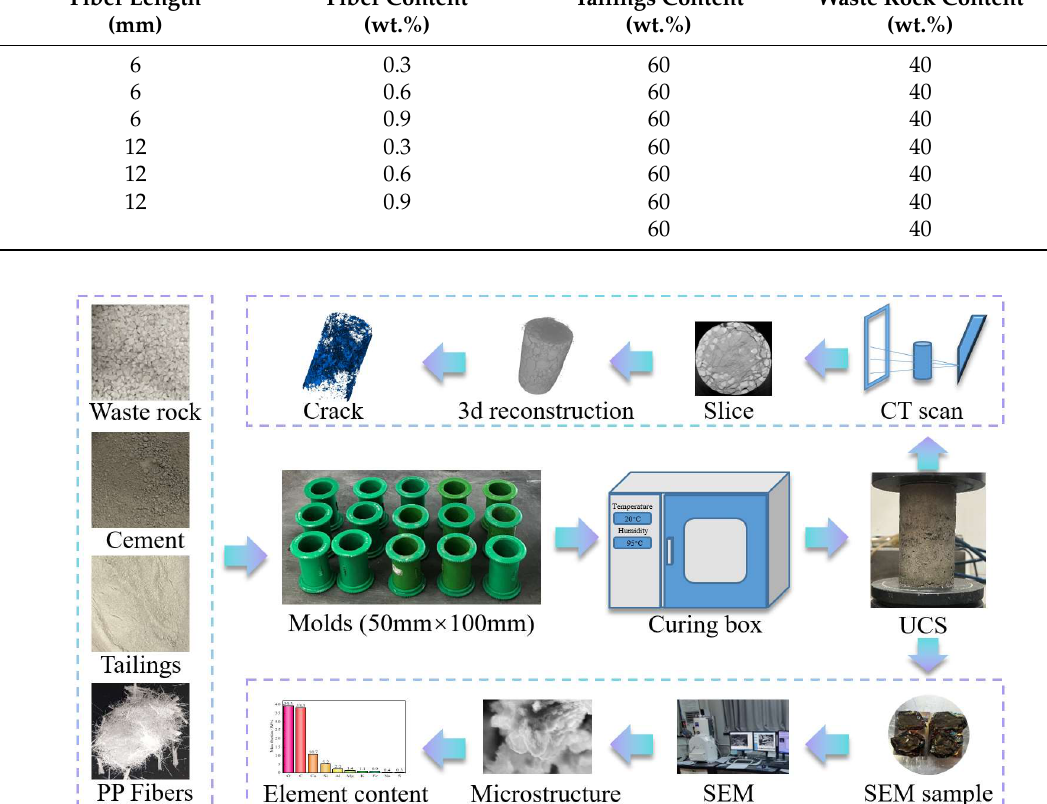
Figure 2. A flow chart of specimen preparation processes, including innovative materials/methods.